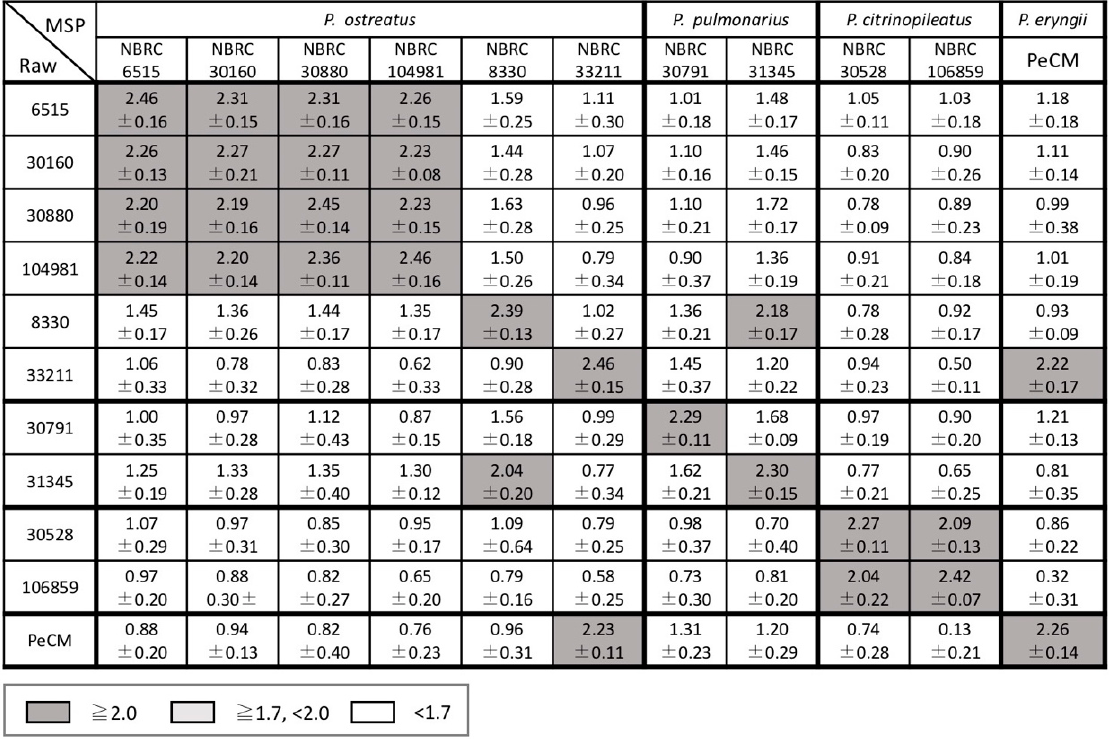
Figure 5. Average identification scores of raw mass spectra and the MSPs of Pleurotus . The scores presented are between 0 and 3: ≥ 2.0 (gray cells) was accepted for reliable identification to the species level; ≥ 1.7 and < 2.0 (light gray cells) was accepted for identification to the genus level; and < 1.7 (white cells) indicated unreliable identification of fungi.